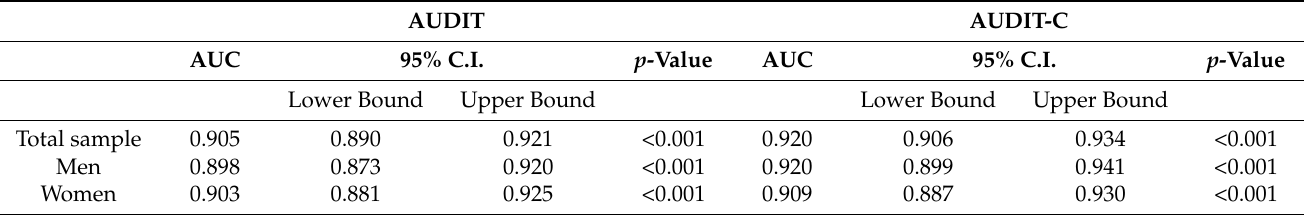
Table 2. Area Under the Curve